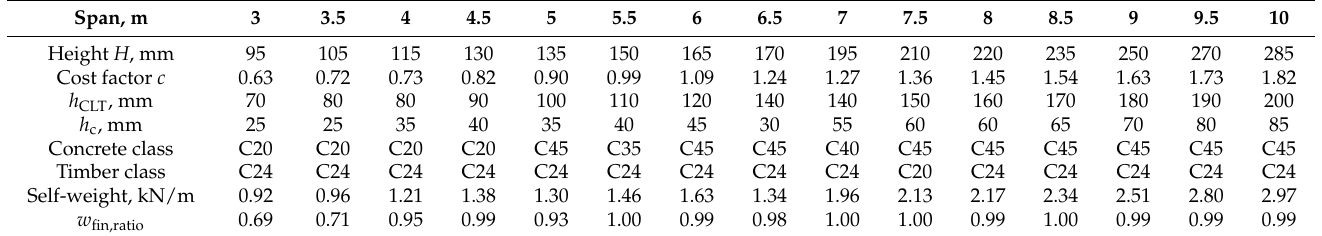
Table 6. The most rational cross-sectional parameters of the CLT–concrete composite panel for cat- egory B.